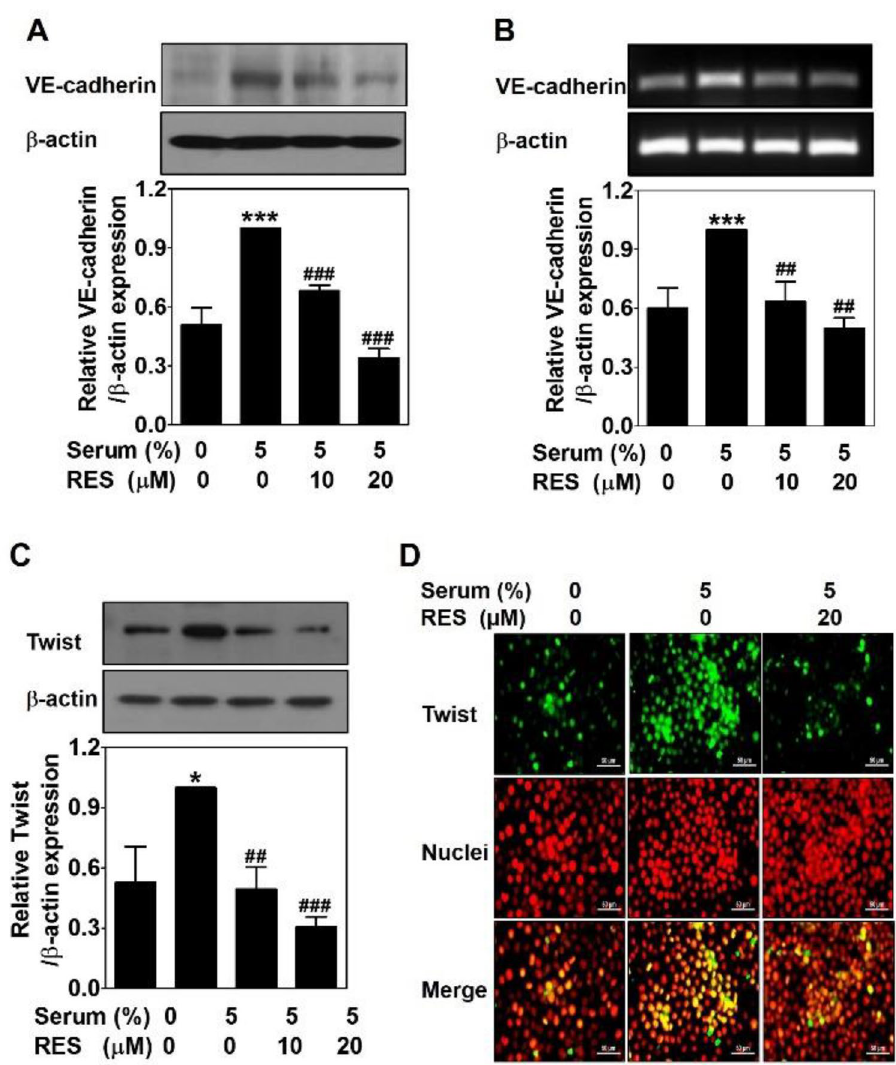
Figure 5. Resveratrol down-regulates serum-induced VE-cadherin expression through decreasing the nuclear twist expression in PC-3 cells. Cells were treated with serum with or without RES for 24 h. ( A ) The same amount of proteins (25–30 μg) were analyzed by Western blot using the VE-cadherin antibody. As a loading control, β-actin was used. ( B )) The mRNA levels were analyzed by RT-PCR using the VE-cadherin primer. As a loading control, β-actin primer was used. ( C ) The same amount of proteins (25–30 μg) were analyzed by Western blot using the twist antibody. β-actin was used as a control. Data present as the means ± SD of three independent experiments by analysis of Student’s t- test. * p < 0.05 and *** p < 0.001 versus untreated control; ## p < 0.01 and ### p < 0.001 versus serum-treated control. ( D ) The serum-treated cells with or without RES for 24 h were fixed, permeabilized and blocked. After probing with Twist antibody followed by incubation with fluorescein isothiocyanate (FITC)-conjugated secondary antibody, the cells were counterstained with propidium iodide (PI). The images were taken with a fluorescence microscope at 400 × . Scale bar = 50